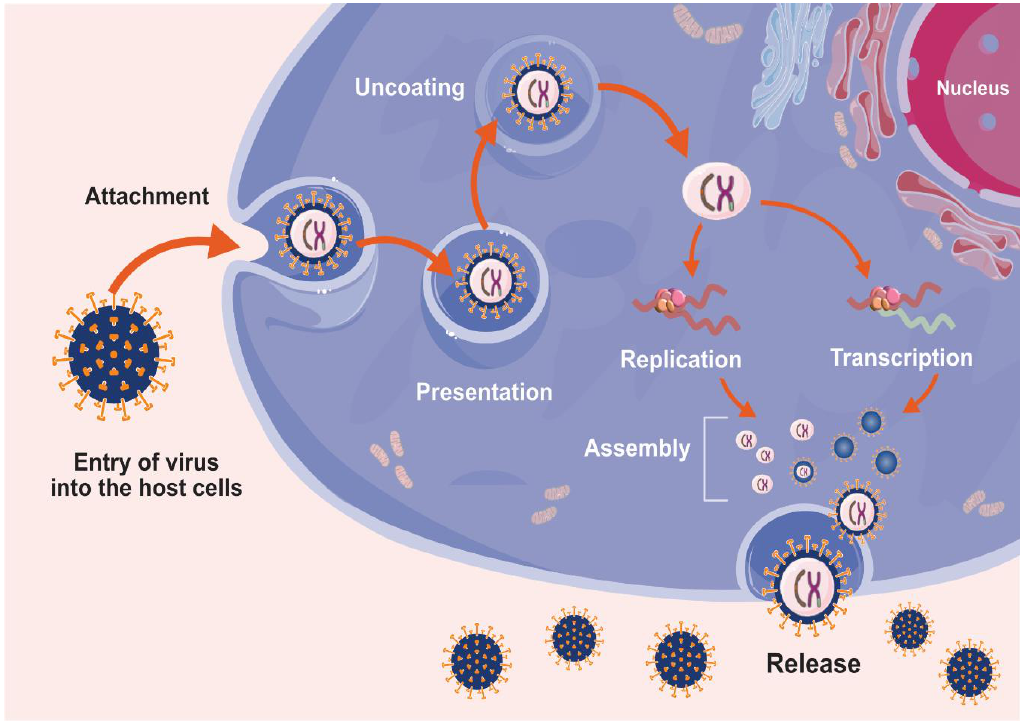
Figure 1. Mechanism of virus entry and replication in host cells.